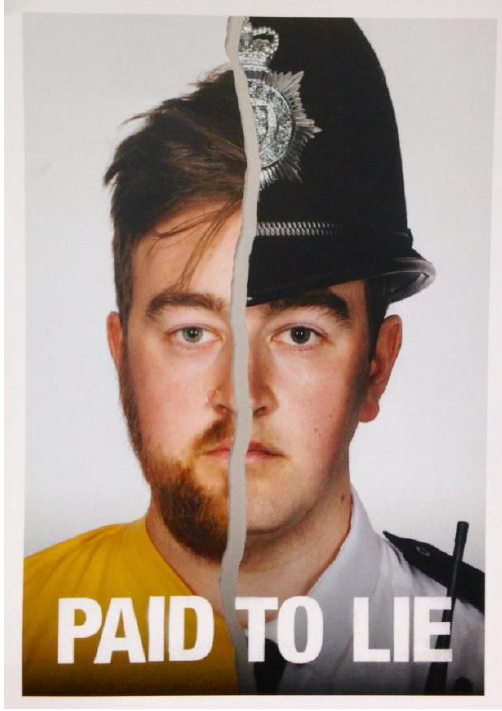
Figure 1 : Lush ‘paid to lie’ campaign